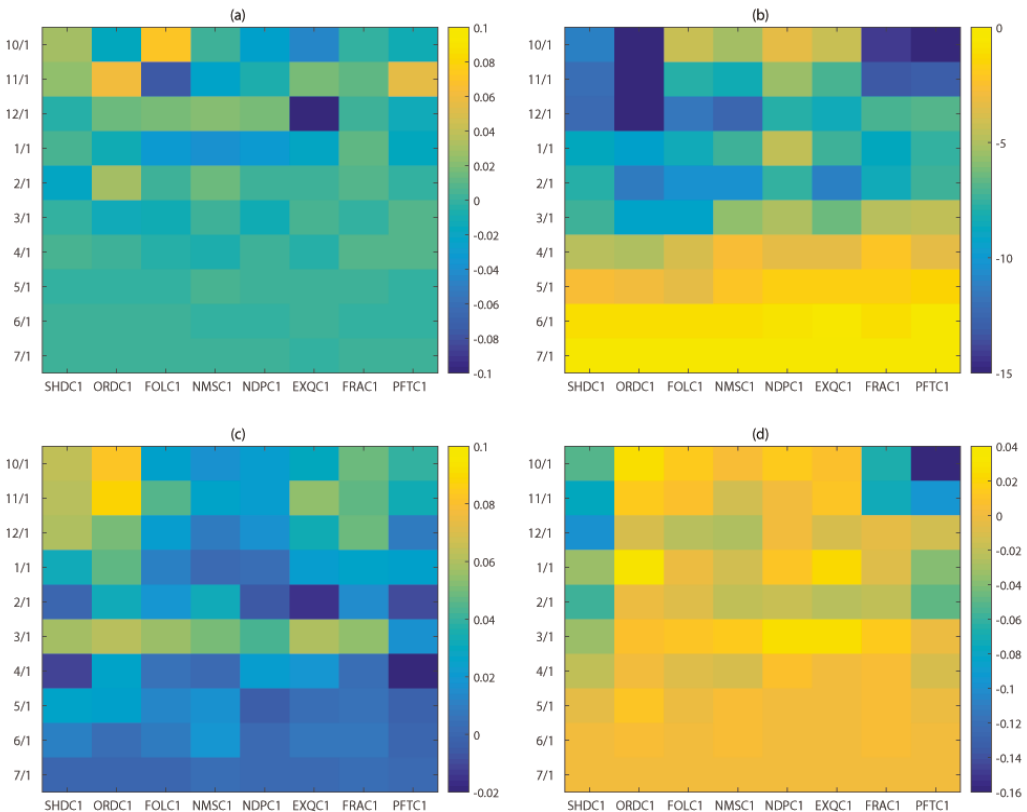
Figure 8. Differences between the statistical metrics of median forecasts and mean forecasts: ( a ) rank correlation; ( b ) percent bias (%); ( c ) mean absolute error skill score and ( d ) Nash–Sutcliffe efficiency on the monthly scale. X-axis shows the study area and Y-axis indicates the forecast issue date.